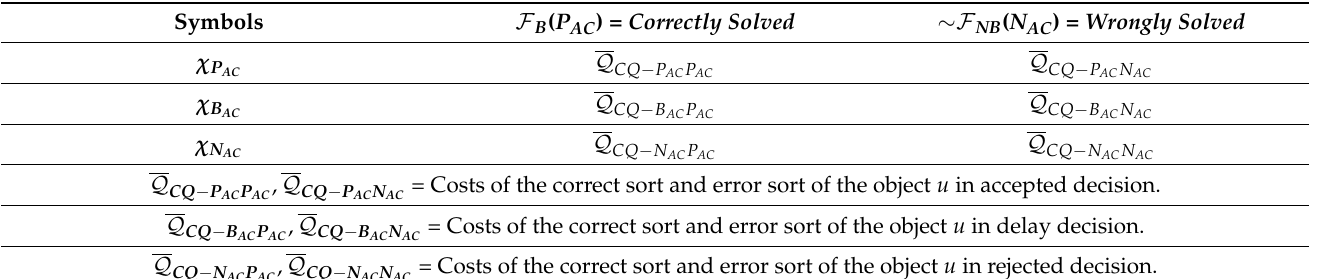
Table 1. Loss functions of DTRS for